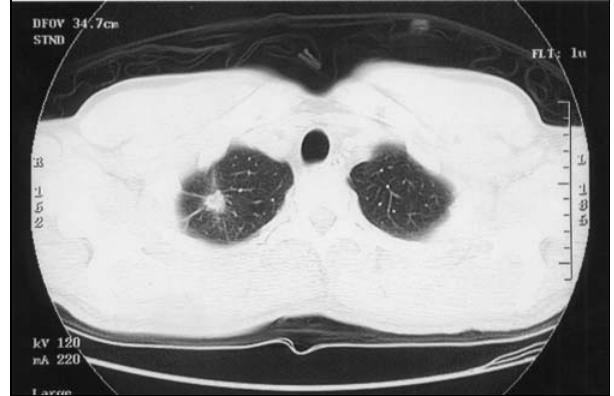
Figure 2) A repeat Computerized Tomography (CT) scan of the tho- rax several months later shows significant improvement of the